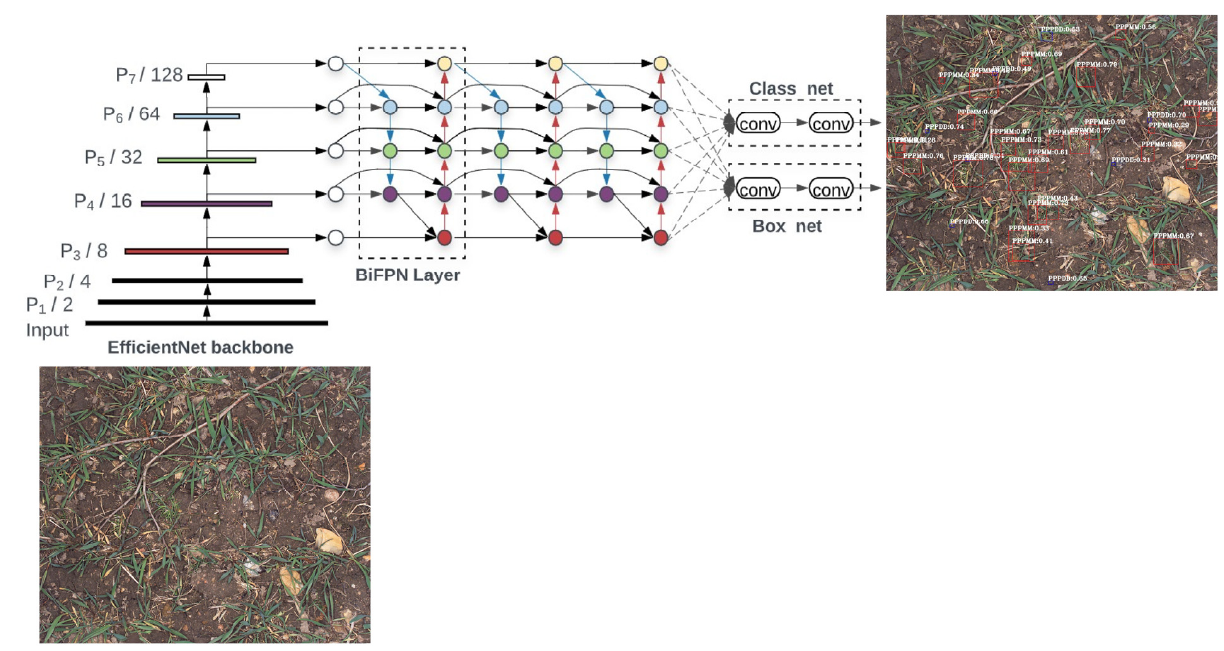
Figure 5. The EfficientDet architecture [33].